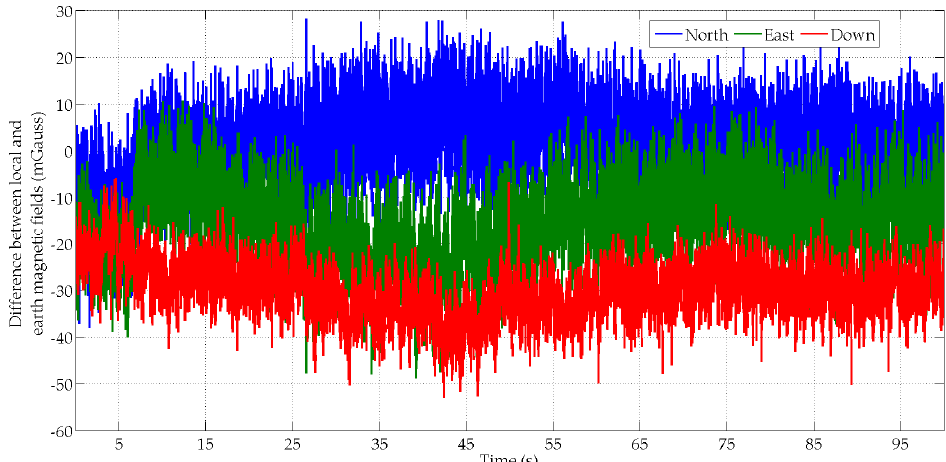
Figure 5 . Illustration of the accelerometer’s norm for subject S1 in the texting scenario.